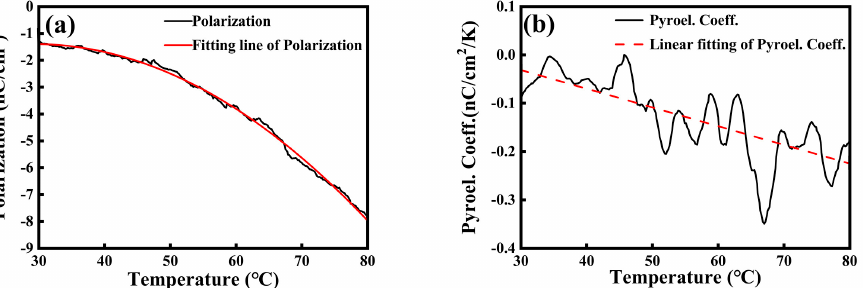
Figure 5. ( a ) Polarization (Ps) and ( b ) pyroelectric coefficient (P) of